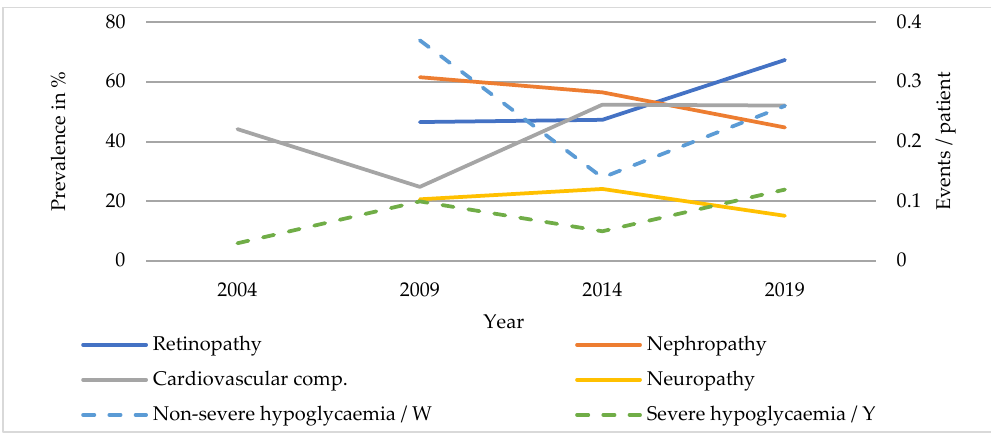
Figure 4. Diabetic complications of patients with T2DM in TC.